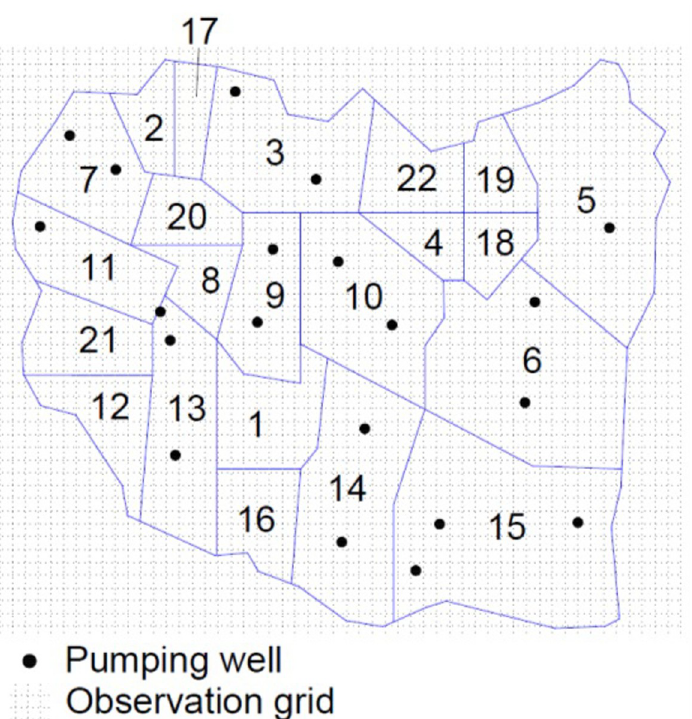
Fig 12. Large-scale test case experimental design